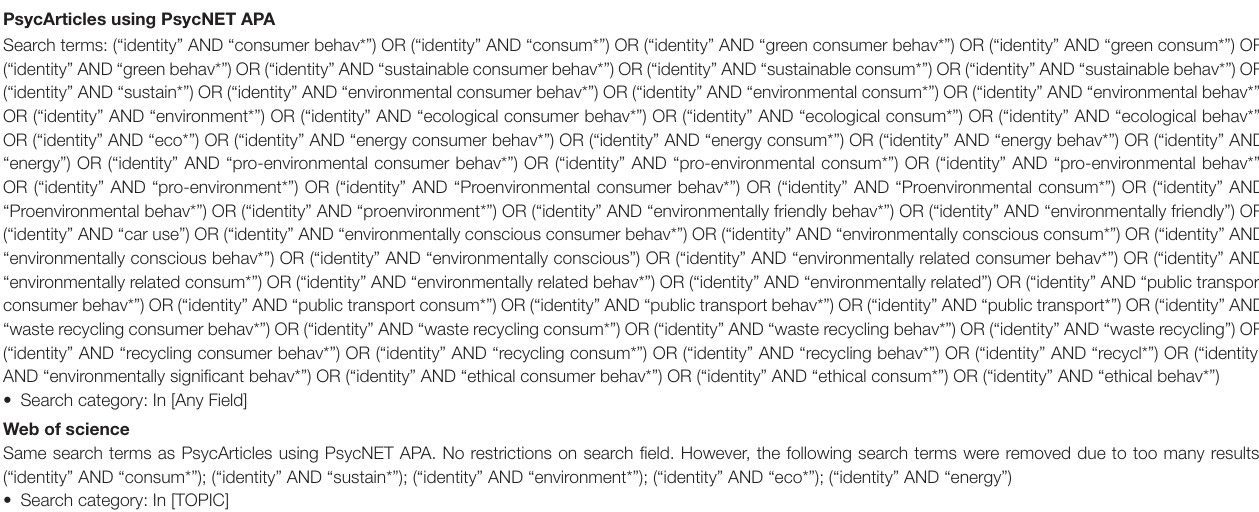
TABLE 1 | Search terms for all databases with search categories and filters. PsycArticles using PsycNET